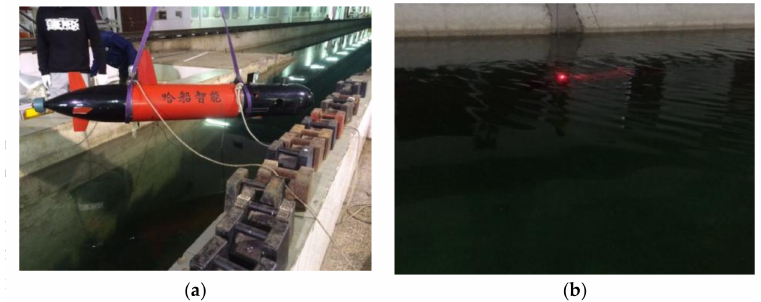
Figure 10. White Dolphin-100 Unmanned Underwater Vehicle: ( a ) White Dolphin-100 UUV ready to be launched into the water; ( b ) White Dolphin-100 UUV during the